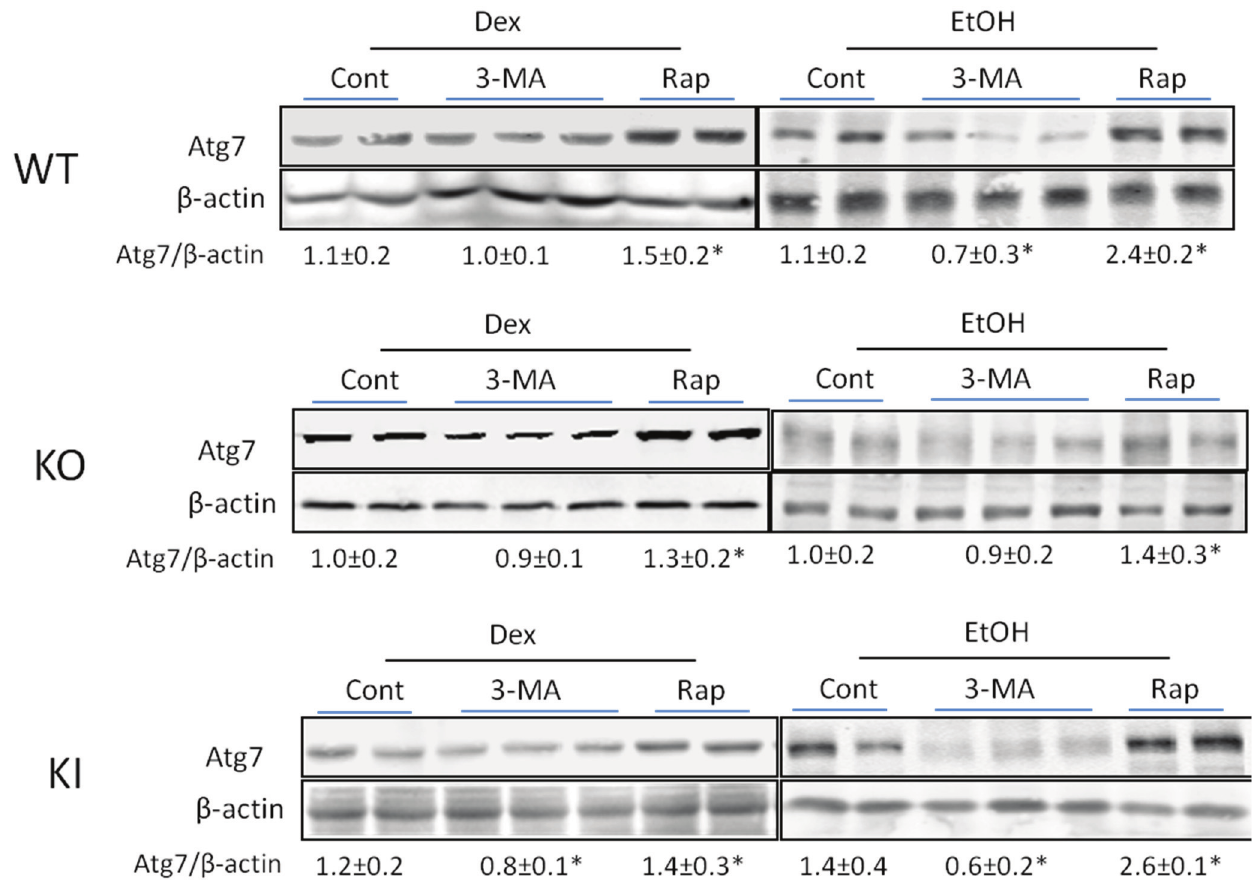
Figure 6. Effect of chronic ethanol or ethanol plus 3-MA or rapamycin on levels of Atg 7. Atg 7 levels in WT, KO and KI mice fed with alcohol or dextrose with or without 3-MA or rapamycin administration were determined by immunoblots. *, p < 0.05 compared with alcohol-fed alone or dextrose fed alone mice. Results are calculated from four mice in each group, N = 4, although two to three blots are